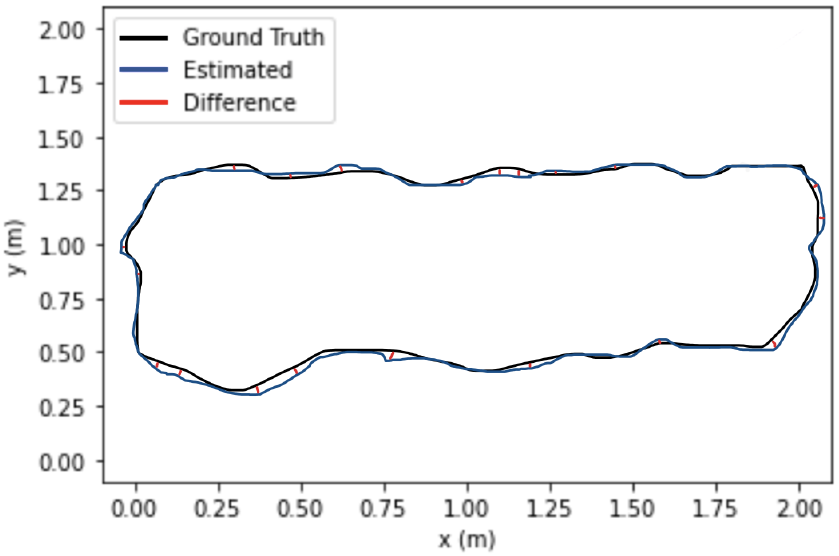
Figure 10. Absolute Trajectory Error (RMSE) of ORB-SLAM3 /